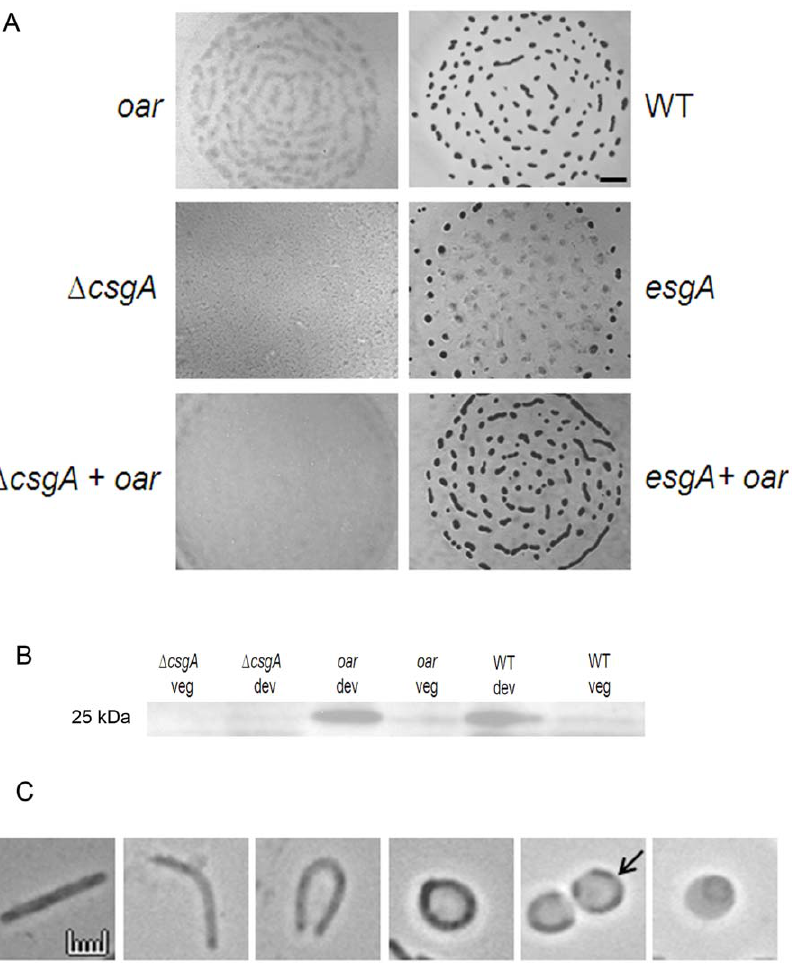
Figure 2. Role of oar in cell signaling. (A) Extracellular complementation of oar (LS2453) cells with D csgA (LS2441) and esg (JD300). WT (DK1622) cells were used as a control. Bar is 1 mm (B) Western blot analysis of vegetative cells and 24 h developing cells using anti-CsgA primary antibody. (C) Morphology of oar cells during development. The first panel represents 24 h developing WT cells while the subsequent panels represent various oar cell shapes as they ultimately transform into spheroplast (extreme right panel). Bar is 1 m